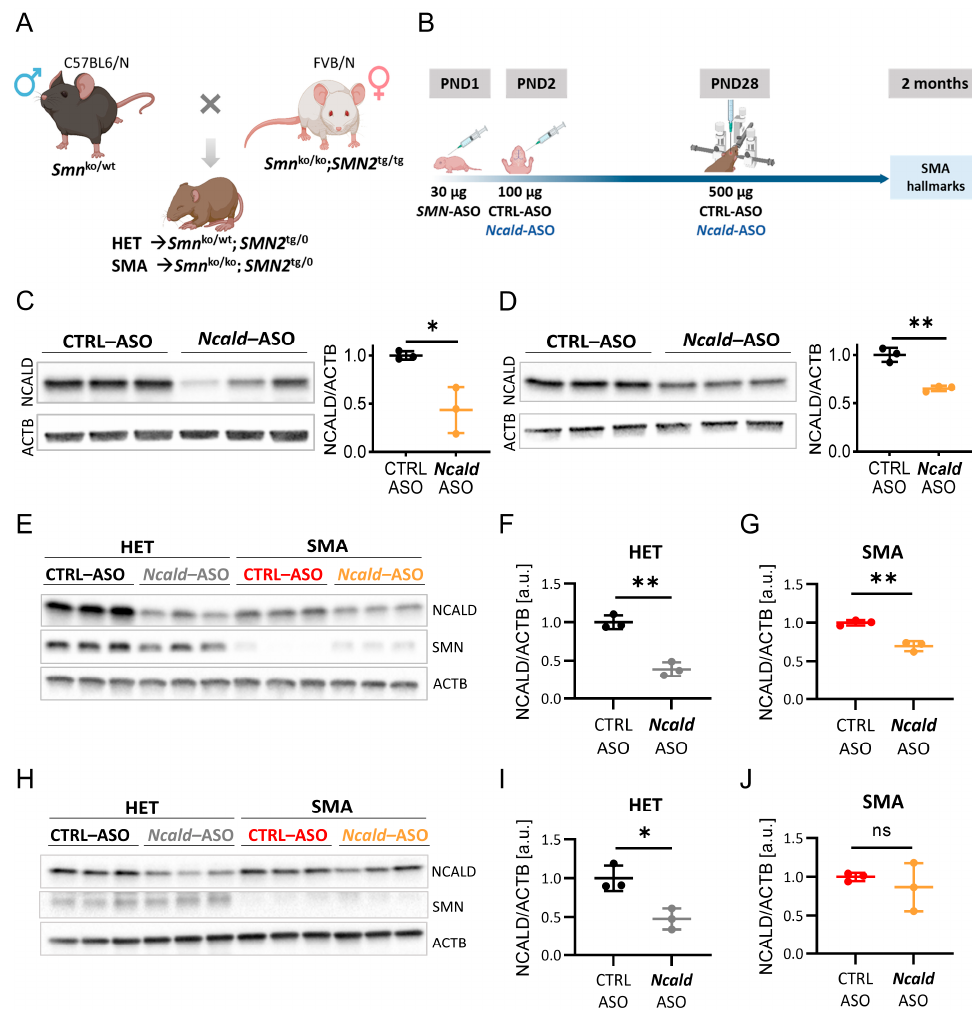
Figure 1. Experimental scheme and efficacy of 500 µ g Ncald -ASO i.c.v bolus re-injection in adult mice. ( A ) Breeding strategy to obtain intermediate SMA and HET mice on mixed50 background. Figure created with BioRender.com. ( B ) Scheme showing combinatorial therapy of SMA and HET mice (latter used as controls) with SMN- and either CTRL- or Ncald -ASOs. Figure created with BioRender.com. ( C , D ) Western blot analysis and quantification of NCALD levels in brain ( C ) and spinal cord ( D ) lysates from CTRL- or Ncald -ASO-treated wild-type mice at PND28; samples were collected 2-weeks after injection. Two-weeks post i.c.v bolus injection with 500 µ g Ncald -ASO, NCALD levels in the brain and spinal cord are significantly reduced compared to CTRL-ASO-treated animals. Unpaired two-tailed Student‘s t -test. All values reported as mean and error bars represent ± SD. * p ≤ 0.05, ** p ≤ 0.01. Each dot in the bar graphs represents an independent animal. ( E – G ) Western blot analysis and quantification of NCALD levels in brain lysates from ASO-treated experimental animals. Samples were collected 4-weeks after treatment. Four-weeks post i.c.v bolus injection with 500 µ g Ncald -ASO, HET and SMA mice showed significantly reduction of NCALD amount compared to CTRL-ASO-treated animals. Unpaired two-tailed Student‘s t -test. All values reported as mean and error bars represent ± SD. ** p ≤ 0.01. Each dot in the bar graphs represents an independent animal. ( H – J ) Western blot analysis and quantification of NCALD levels in spinal cord lysates from ASO-treated experimental animals. Samples were collected 4-weeks after i.c.v bolus injection at PND28 with 500 µ g Ncald -ASO, HET but not SMA mice showed significantly reduced NCALD protein amount compared to CTRL-ASO-treated animals. Unpaired two-tailed Student‘s t -test. All values reported as mean and error bars represent ± SD. * p ≤ 0.05. Each dot in the bar graphs represents an independent animal. ns = not